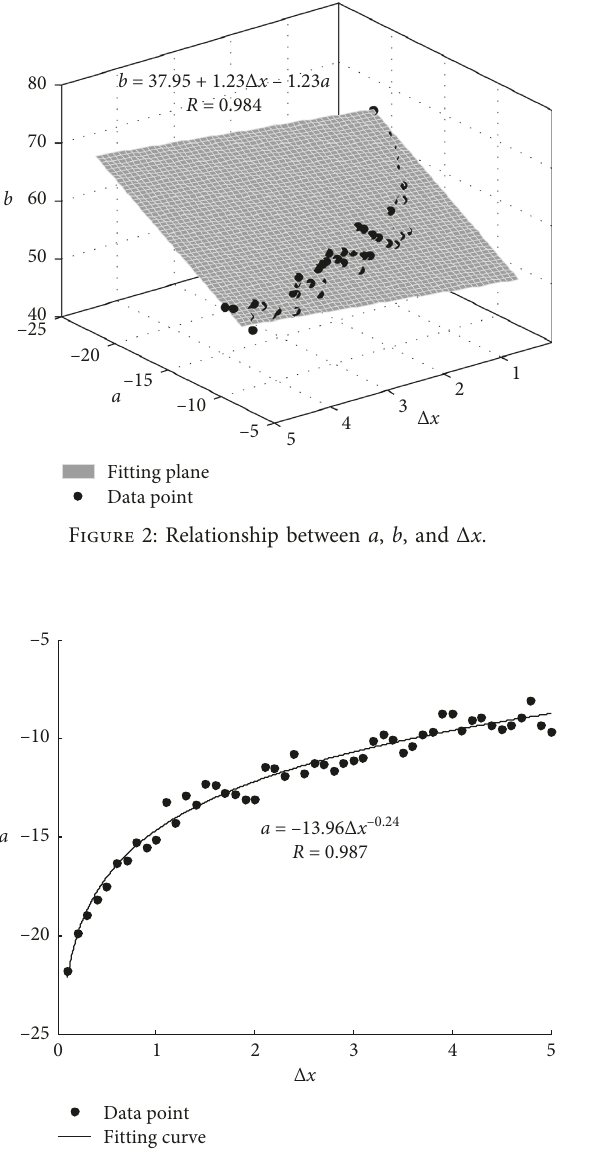
Figure 5: Relationship between b / a and Δ x .